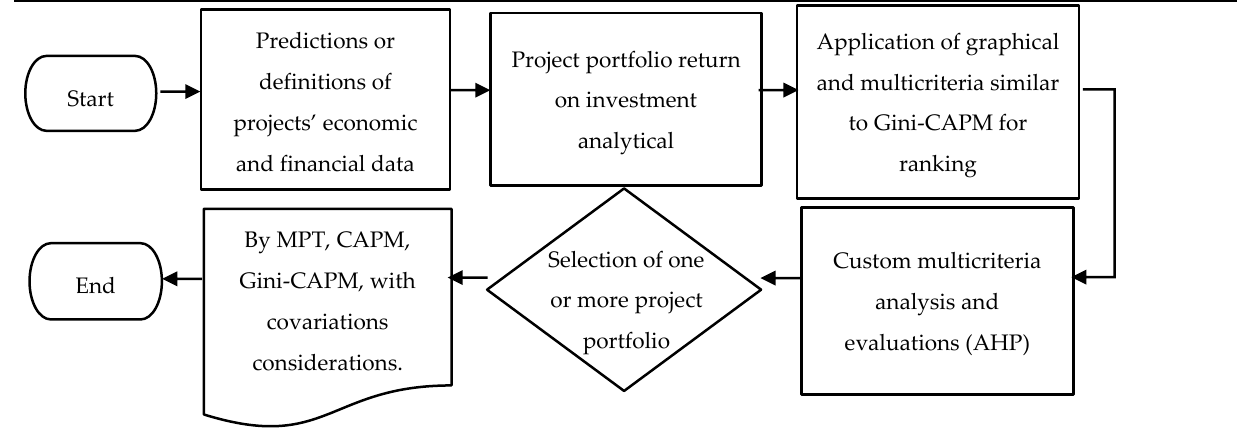
Figure 1. Synthesized method sequence.